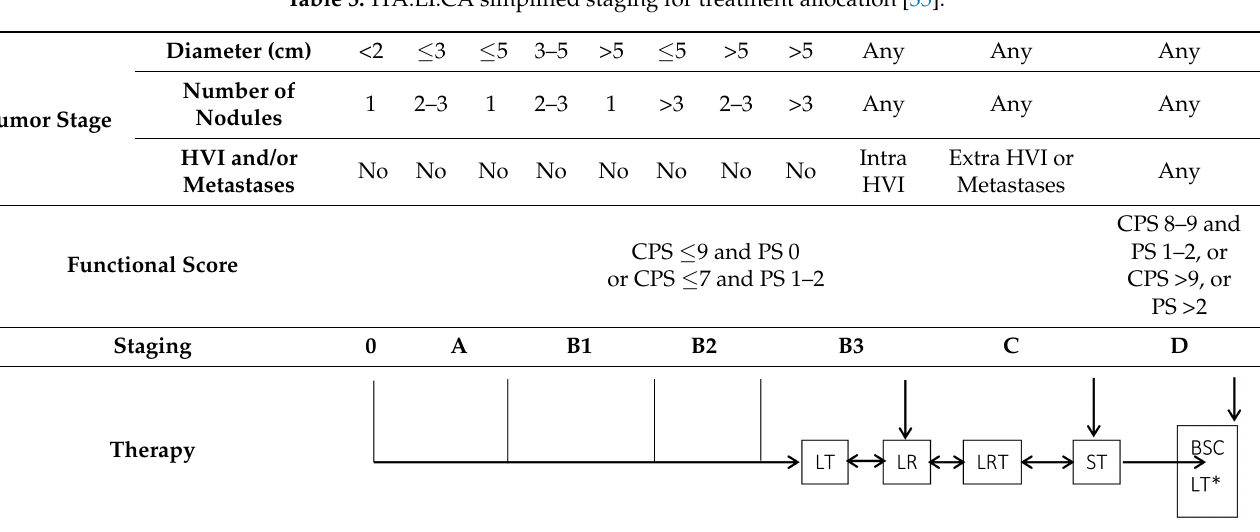
Table 5. ITA.LI.CA simplified staging for treatment allocation